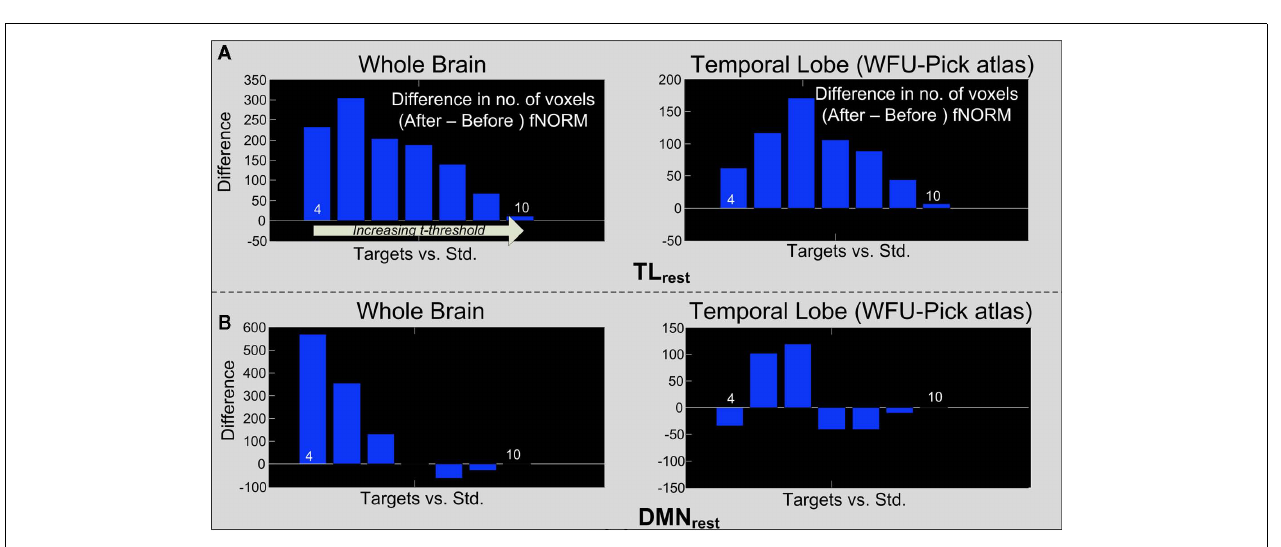
( y -axis) after ICA-fNORM for increasing t -threshold ( x -axis). Differences are presented for whole brain (left) and temporal lobe ROI extracted usingWFU Pick Atlas (right) for each template: (A) TL rest and (B) DMN rest